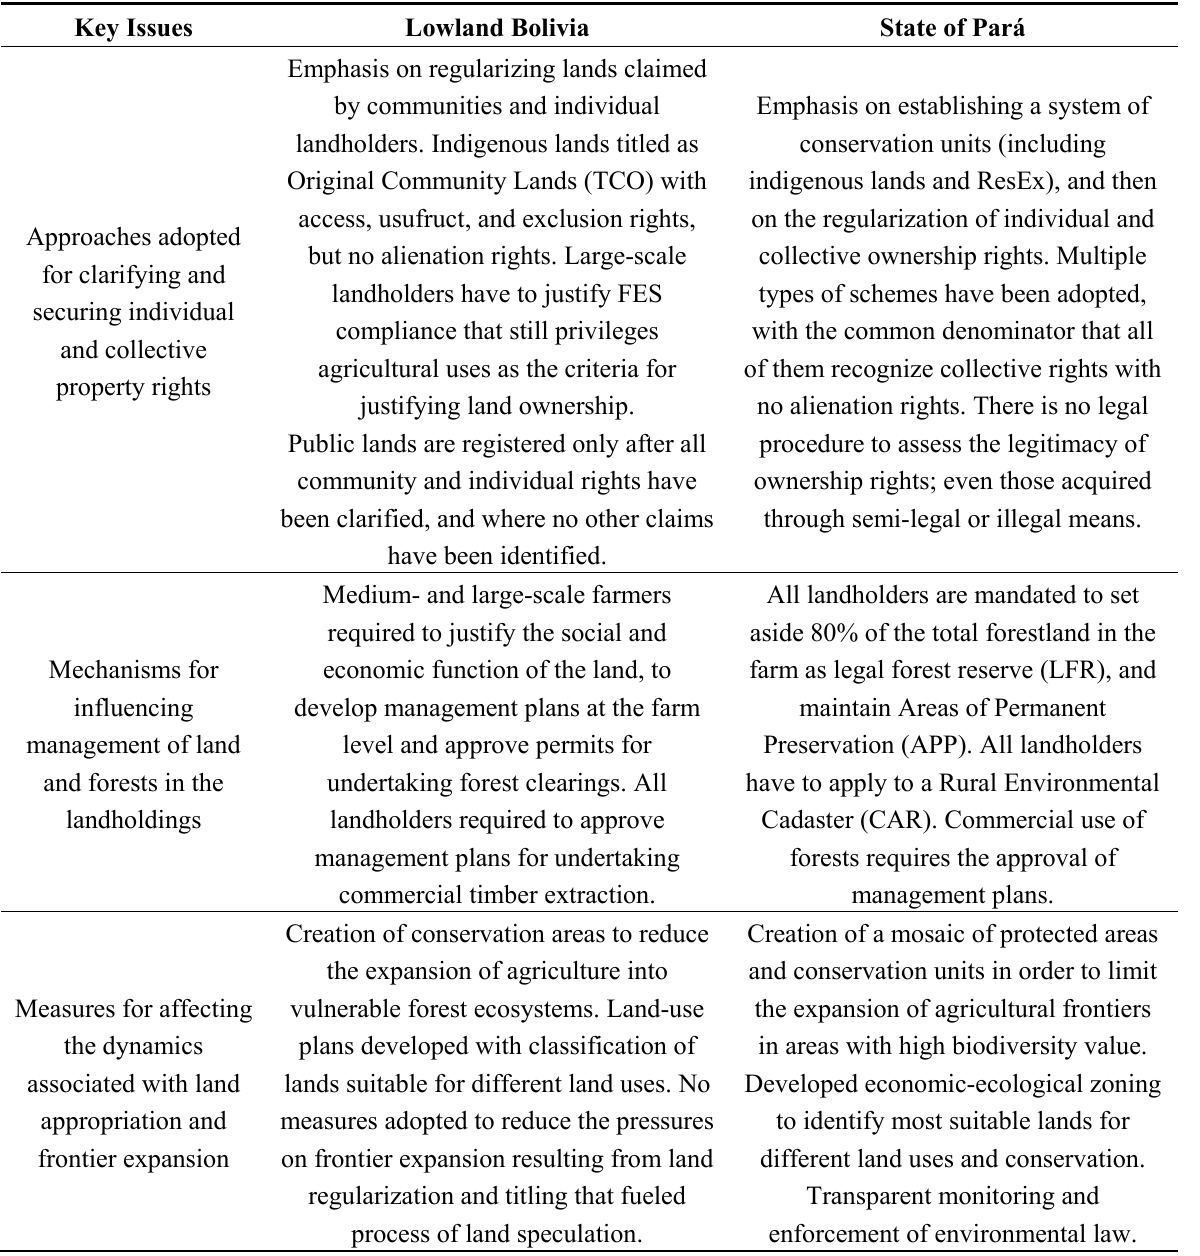
Table 4. Commonalities and differences in policy approaches in Bolivia and